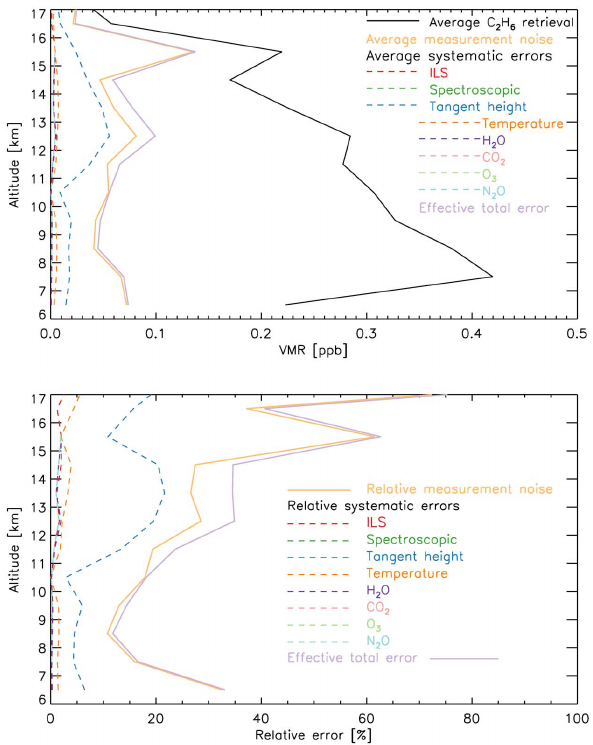
Fig. 3. Top panel: Mean VMR profile of C 2 H 6 (black) for the 25 occultations selected for the error budget calculations and the absolute value of the contribution of each component. Lower panel: Relative contribution of each of the components considered in the error budget calculation. In purple in both panels is the effective total error.